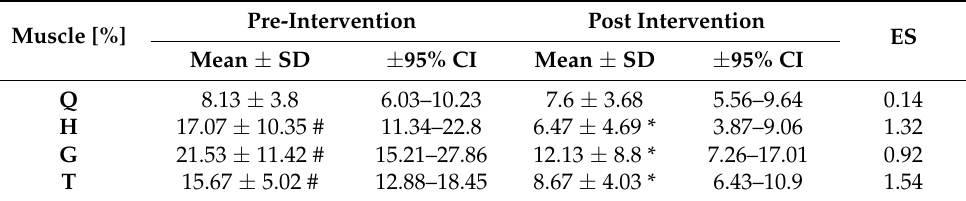
Table 1. Difference in muscle activity imbalance between and within pre- and post-intervention for the quadriceps (Q), hamstrings (H), gluteal muscles (G), and for the total activity of these muscles (T). Pre-Intervention Post Intervention Muscle [%] ES Mean ± SD ± 95% CI Mean ± SD ± 95% CI Q 8.13 ± 3.8 6.03–10.23 7.6 ± 3.68 5.56–9.64 0.14 H 17.07 ± 10.35 # 11.34–22.8 6.47 ± 4.69 * 3.87–9.06 1.32 G 21.53 ± 11.42 # 15.21–27.86 12.13 ± 8.8 * 7.26–17.01 0.92 T 15.67 ± 5.02 # 12.88–18.45 8.67 ± 4.03 * 6.43–10.9 1.54 Quadriceps muscles (Q), hamstring muscles (H), gluteal muscles (G), total activity (T); SD—standard deviation, CI—confidence interval; ES—effect size; * significant difference between pre- and post-intervention values p <